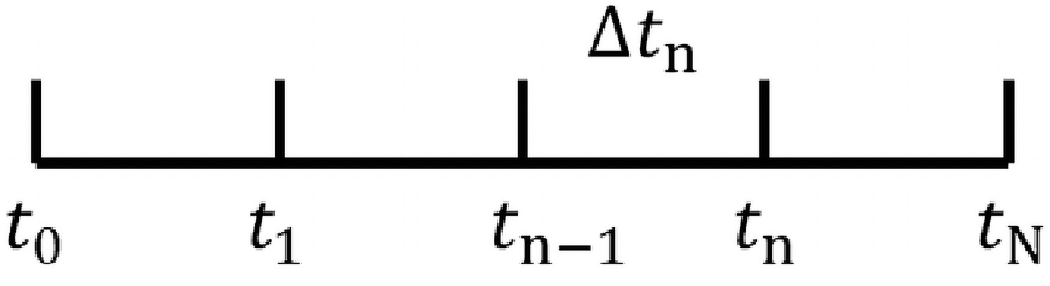
Fig 3. Parameters for the time